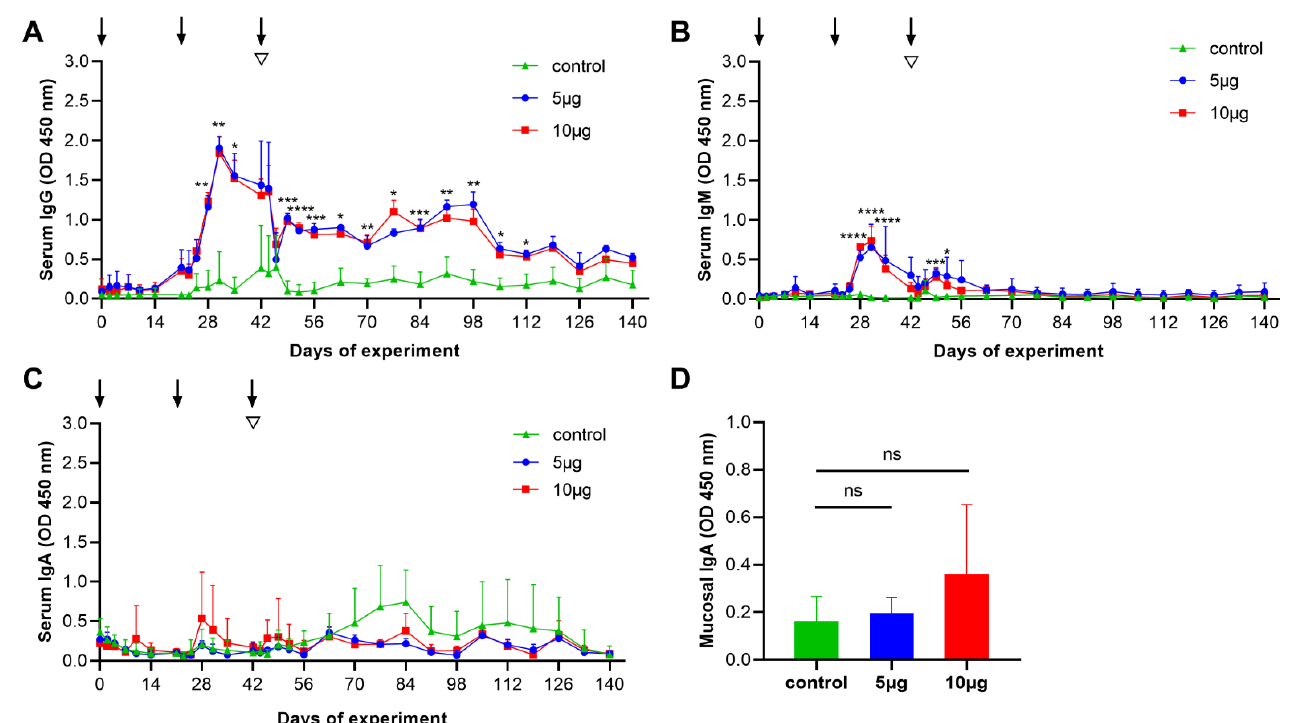
Figure 3. Serum and mucosal antibody responses of goats vaccinated with adjuvant alone (control), 5 μg , and 10 μg Con A-purified proteins, were measured by enzyme-linked immunosorbent assay (ELISA). ( A – C ) Dynamics of serum IgG ( A ), IgM ( B ) and IgA ( C ) antibody responses to Con A- purified proteins were detected in three experimental groups at 30 time points (see Figure 1). Each data (OD 450 nm) denoted the mean antibody titers (mean ± SD; adjuvant control, n = 4; 5 μg group, n = 3; 10 μg group, n = 5). The three time points (days 0, 21, and 42) of the immunizations are indicated by arrows, and the time point (day 42) of challenge with 7000 third-stage larvae (L3s) is indicated by inverted triangles. ( D ) Each data (OD 450 nm) denoted the mean mucosal IgA antibody titers at the trials (mean ± SD; adjuvant control, n = 4; 5 μg group, n = 3; 10 μg group, n = 5). Statistical significance was determined using the one-way ANOVA, * p < 0.05, ** p < 0.01, *** p < 0.001, **** p < 0.0001, and ns (nonsignificant).